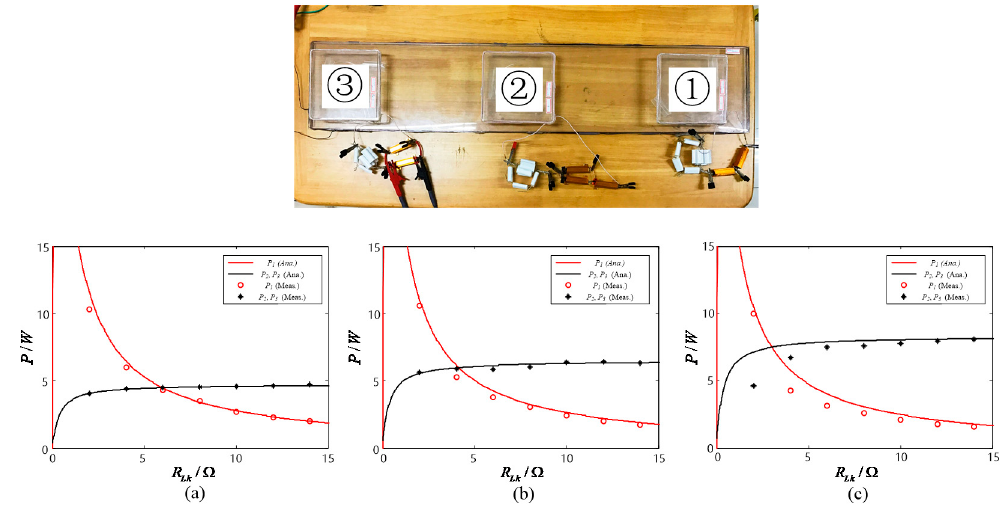
P = 4.5 W; ( b ) P = 6 W; ( c ) P = 7.5 W. 0 0 0